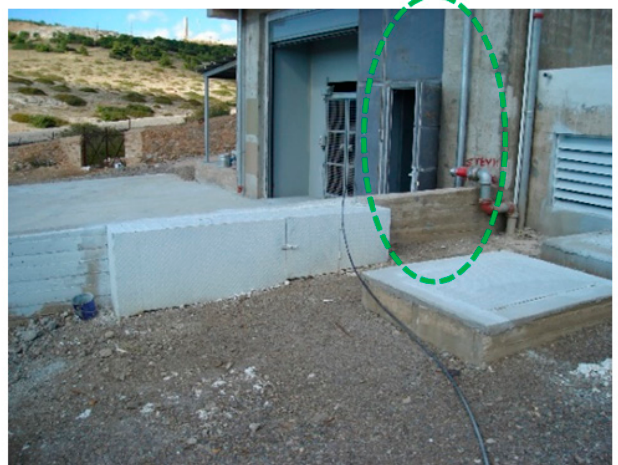
Figure 8. Underground staircase exit.